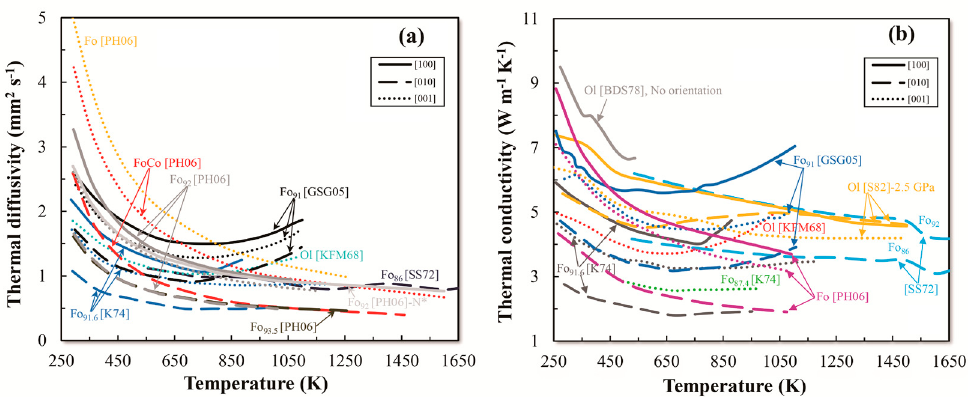
Figure 1. Temperature dependence of D and κ of single crystal olivine. The solid, dotted, and dashed lines denote measurement for the [100], [001], and [010] directions. Data source: KFM68, Kanamori et al. [61]; SS72, Schatz and Simmons [62]; K74, Kobayashi [40]; BDS78, Beck et al. [46]; S82, Scharmeli [64]; GSG05, Gibert et al. [37]; PH06, Pertermann and Hofmeister [42]. ( a ): D . ( b ): κ .